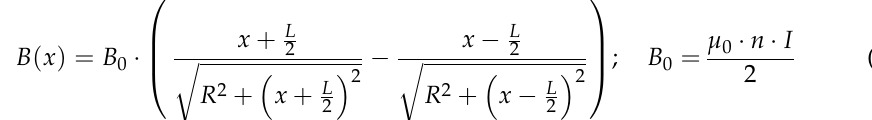
Figure 6. Calculated polarized neutron images: different fringe patterns due to different coil, left: fringe pattern with a square coil, right: fringe pattern with a cylindrical coil. For the { x , z } -plane (and any other plane), one obtains a frequency-dependent contrast function of different fringe patterns with a coil and imaged with polarized neutrons. The magnetic field in a coil of finite length L and radius R, B is given by [50]